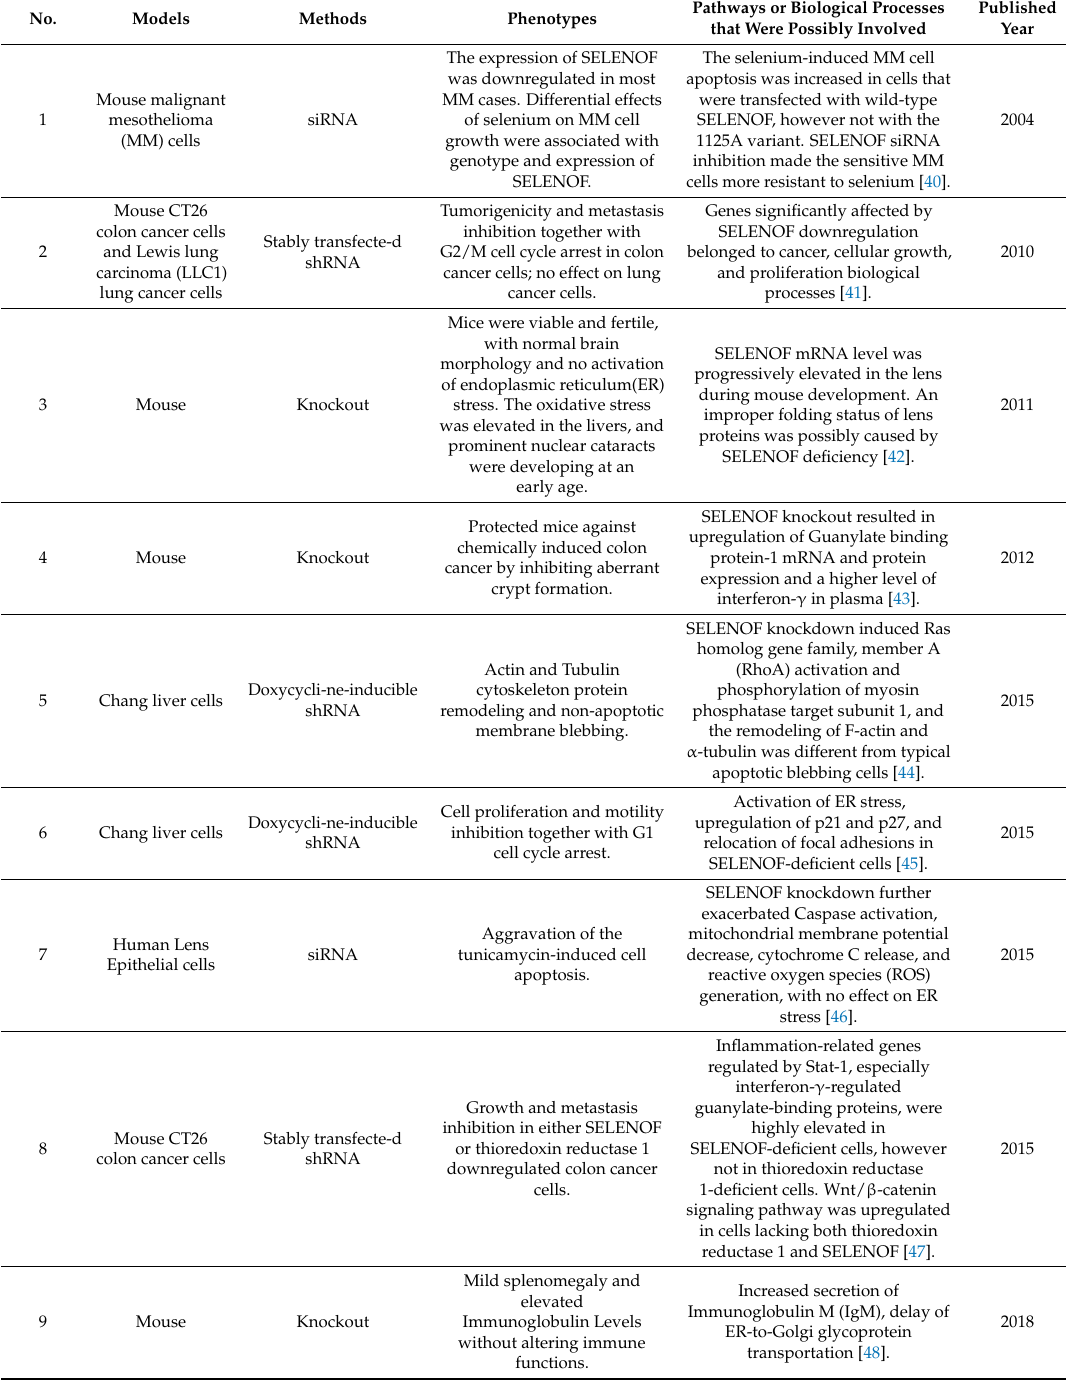
Table 1. Summarization of the SELENOF (Selenoprotein F) knockdown and knockout